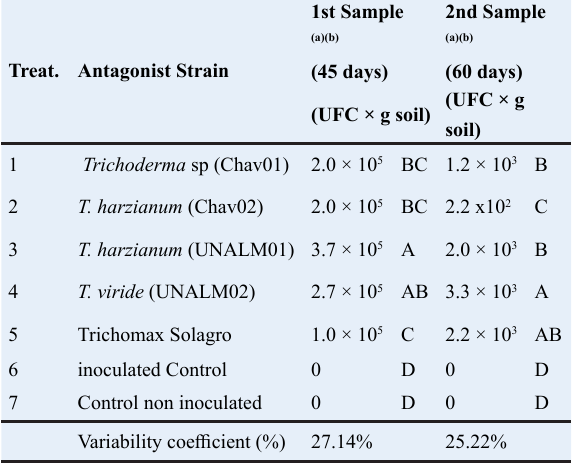
Table 4. Colony-forming units of different Trichoderma strains in roots of Zutano avocado inoculated with Phytophthora cinnamomi